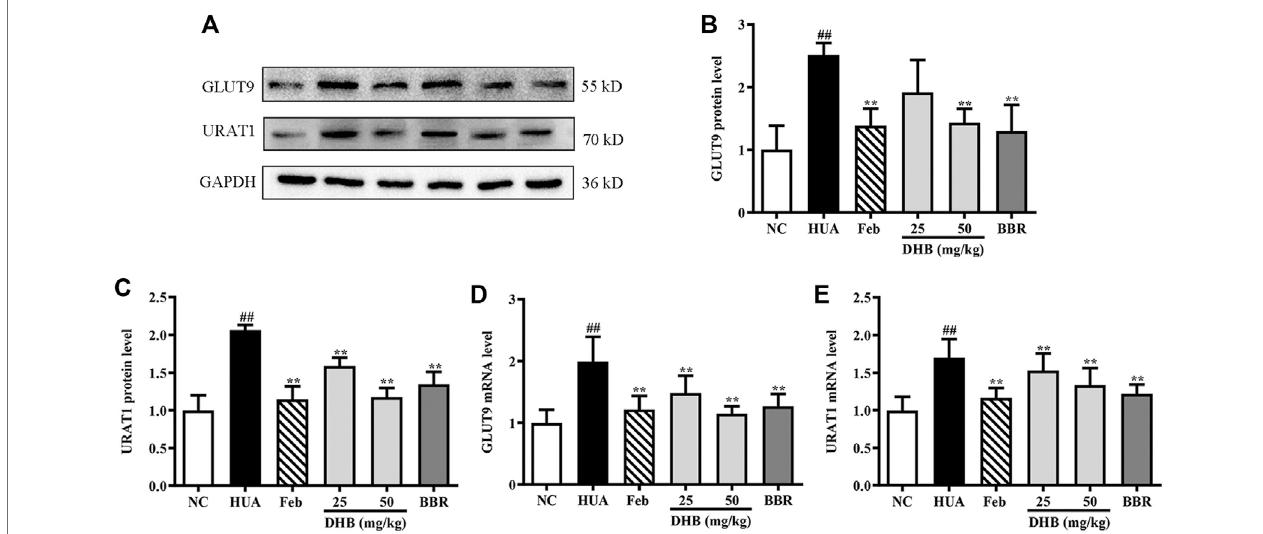
FIGURE 5 | Effect of DHB on renal gene and protein expression of URAT1 and GLUT9 in PO/HX induced hyperuricemic mice. (A) Representative Western blot bands, (B) protein expression of GLUT9, (C) protein expression of URAT1, (D) mRNA expression of GLUT9, (E) mRNA expression of URAT1. The protein and mRNA expressions of GLUT9 and URAT1 were detected by Western blot and RT-qPCR in the renal tissues, respectively. The results are expressed as mean ± SD (n (cid:2) 3 – 5). # p < 0.05, ## p < 0.01, compared with NC group; *p < 0.05, **p < 0.01, compared with HUA group.